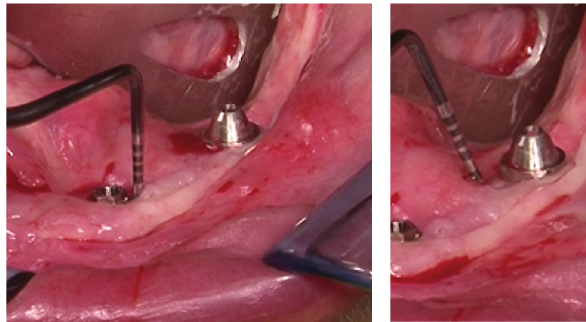
Figure 7: Clinical probing of the peri-implant pockets.